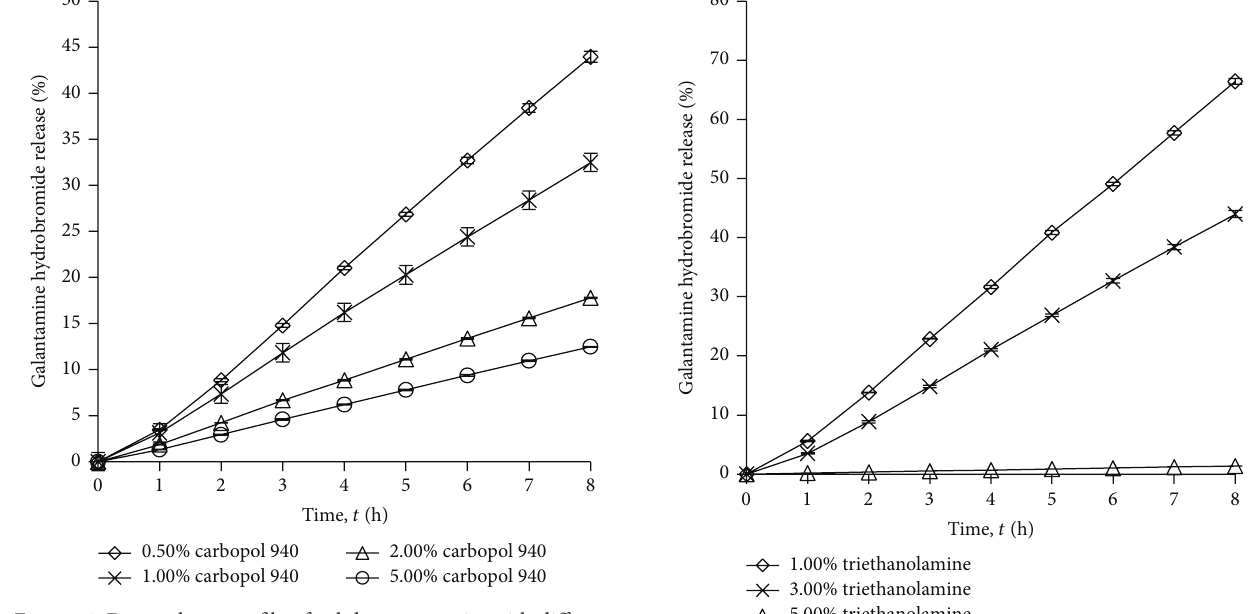
Figure 1: Drug release profile of gel drug reservoirs with different carbopol 940 percentage (mean ± S.D.; 𝑛 = 3 ).